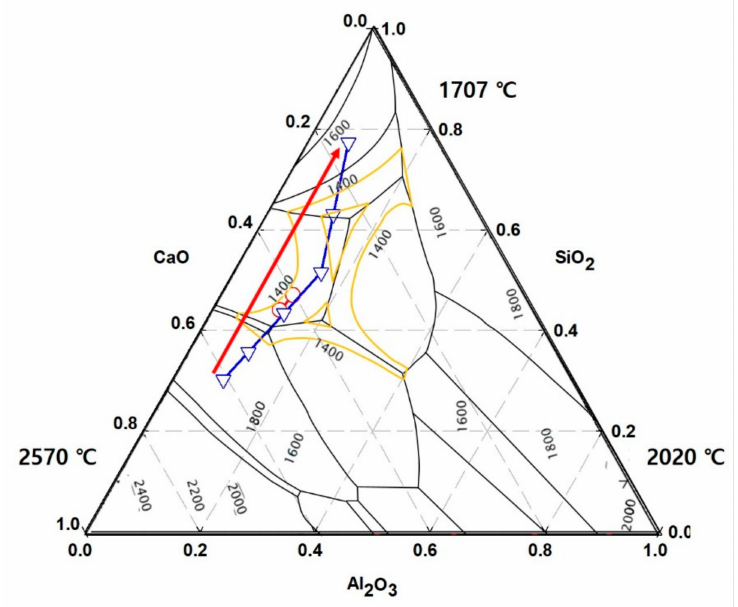
Figure 6. Melting temperatures at different basicity levels ( (cid:53) : Sewage sludge,